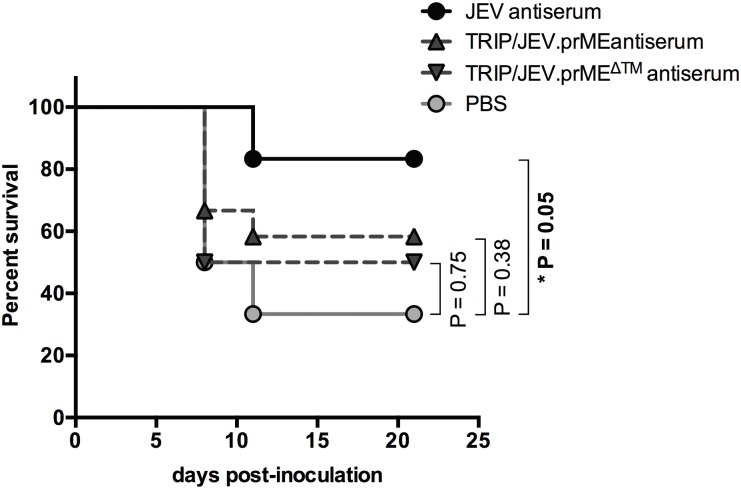
Protective capacity of TRIP/JEV antisera in a mouse model.Groups of 3-week-old C56BL/6 mice received i.p. inoculation with 0.1 ml of DPBS containing 0.01 ml of pooled immune sera collected from JEV-infected mice (JEV G3 antiserum) or TRIP/JEV-inoculated mice two months after boosting. Mice inoculated with DPBS (PBS) served as a group control. One day later, the mice were i.p. challenged with JEV strain RP-9 and observed daily for mortality. Survival was recorded for 21 days. The asterisk indicates that the differences between survival curves are statistically significant (*, P < 0.05, n.s.: P > 0.05).